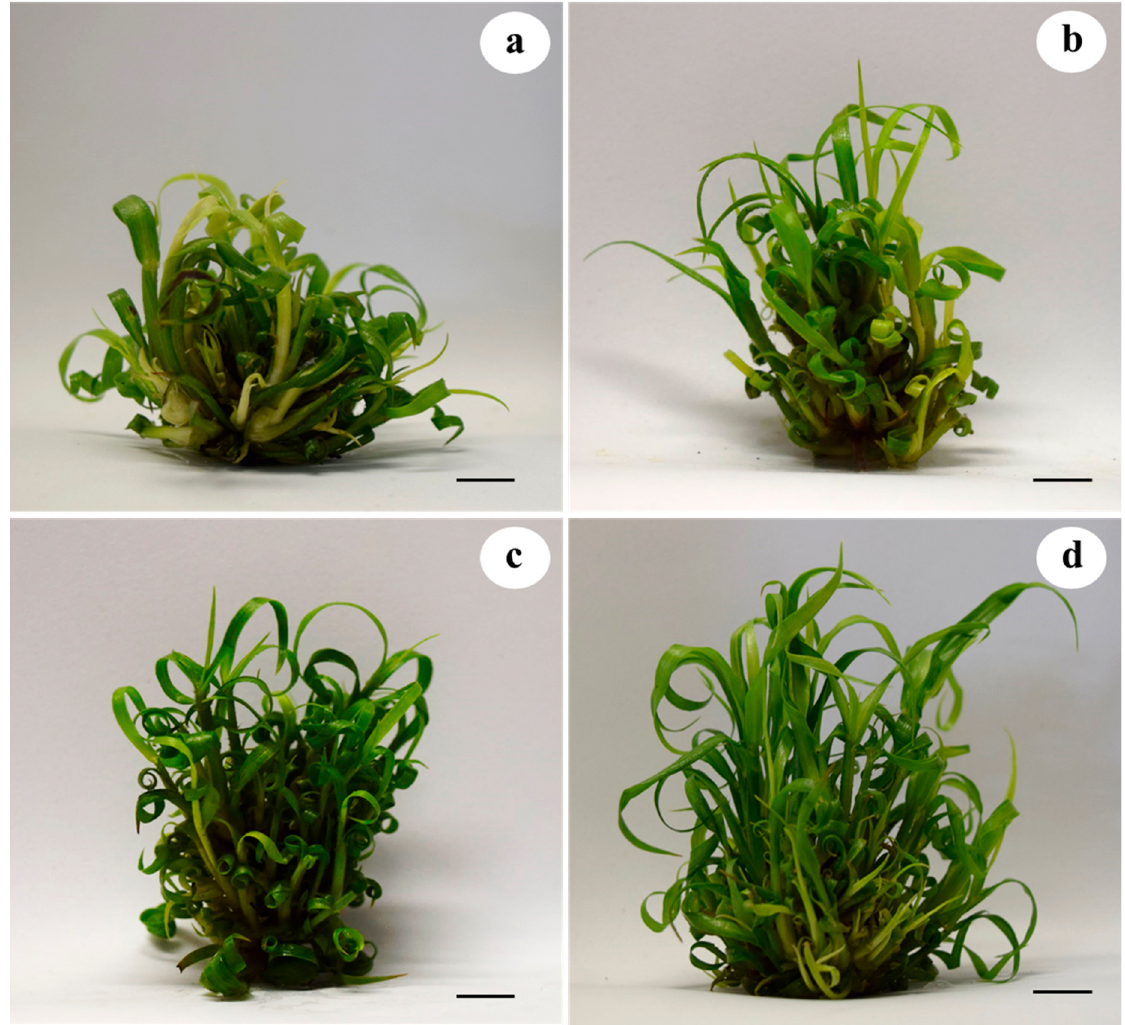
Figure 3. Effect of different MWCNT concentrations on in vitro shoot development of sugarcane ( Saccharum spp.) cv. Mex 69-290 at 30 days in temporary immersion; ( a – d ) 0, 50, 100, and 200 mg L − 1 MWCNT, respectively. Black bar = 1 cm.